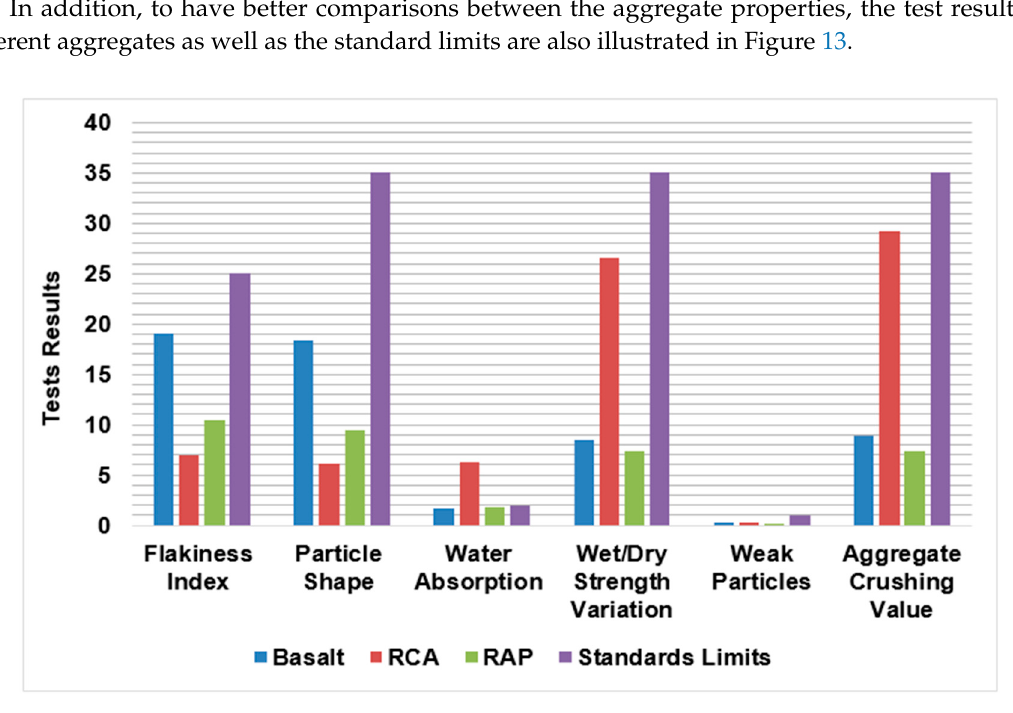
Figure 14. Comparison of Water Absorption and Particle Density of Different Mixes of Coarse Aggregates. As can be observed in Figure 14, increasing RCA in the mix does not make any substantial change in mix density in comparison with water absorption. In other words, by increasing RCA from